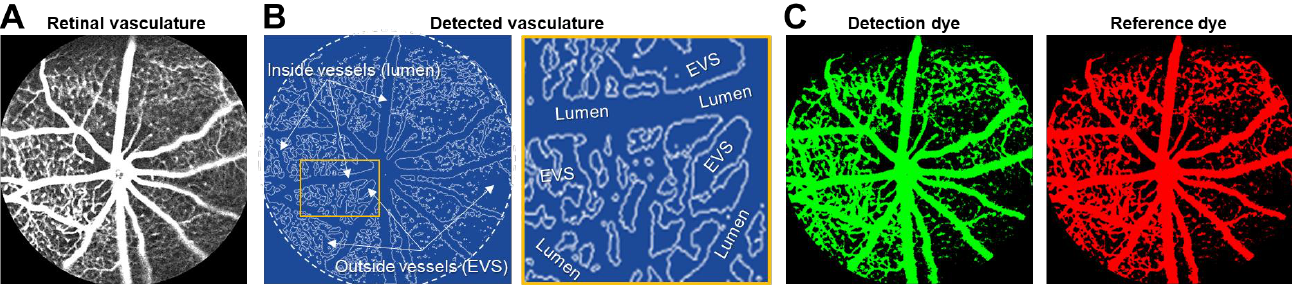
Figure 1. A novel method to noninvasively detect and quantify retinal vascular leakage with dual fluorescence in vivo. ( A ) Representative composite fundus image showing blood vessels in the central and peripheral retina where we performed the leakage analysis. ( B ) Autodetection of the vascular tree by Volocity software, as described in the Methods, which enables measuring of the mean fluorescence intensities (MFI) of the green and red fluorescence-labeled dextrans of the intravenously injected mixture inside the lumen of vessels and outside in the extravascular space (EVS). Shown on the right is a closeup of the area boxed in yellow highlighting the selection of the vessel lumen and EVS where the MFI measurements are obtained. ( C ) Representative fluorescence images of the retinal vascular tree in the green (FITC; left) and red (TRITC; right) channels, in which the MFI measurements inside and outside vessels of each dye are obtained to quantify the vascular leakage.